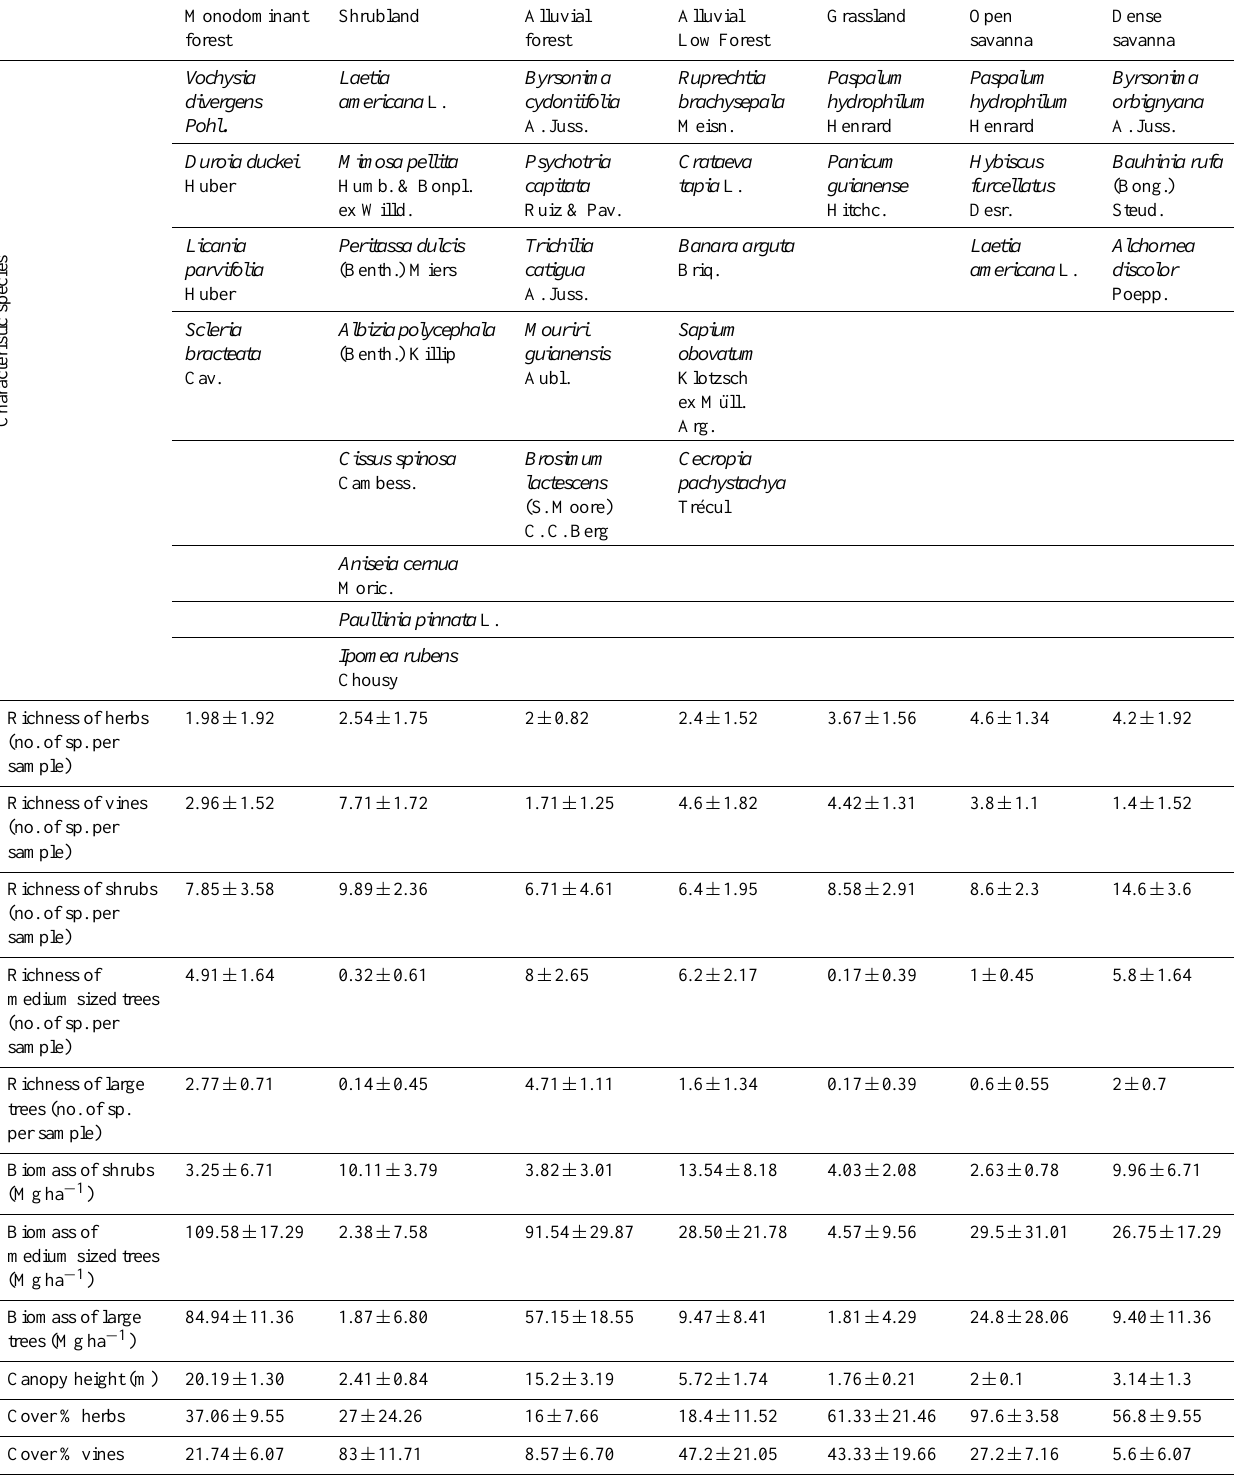
Table 3. Structural and floristic characteristics of plant communities, given as mean and standard